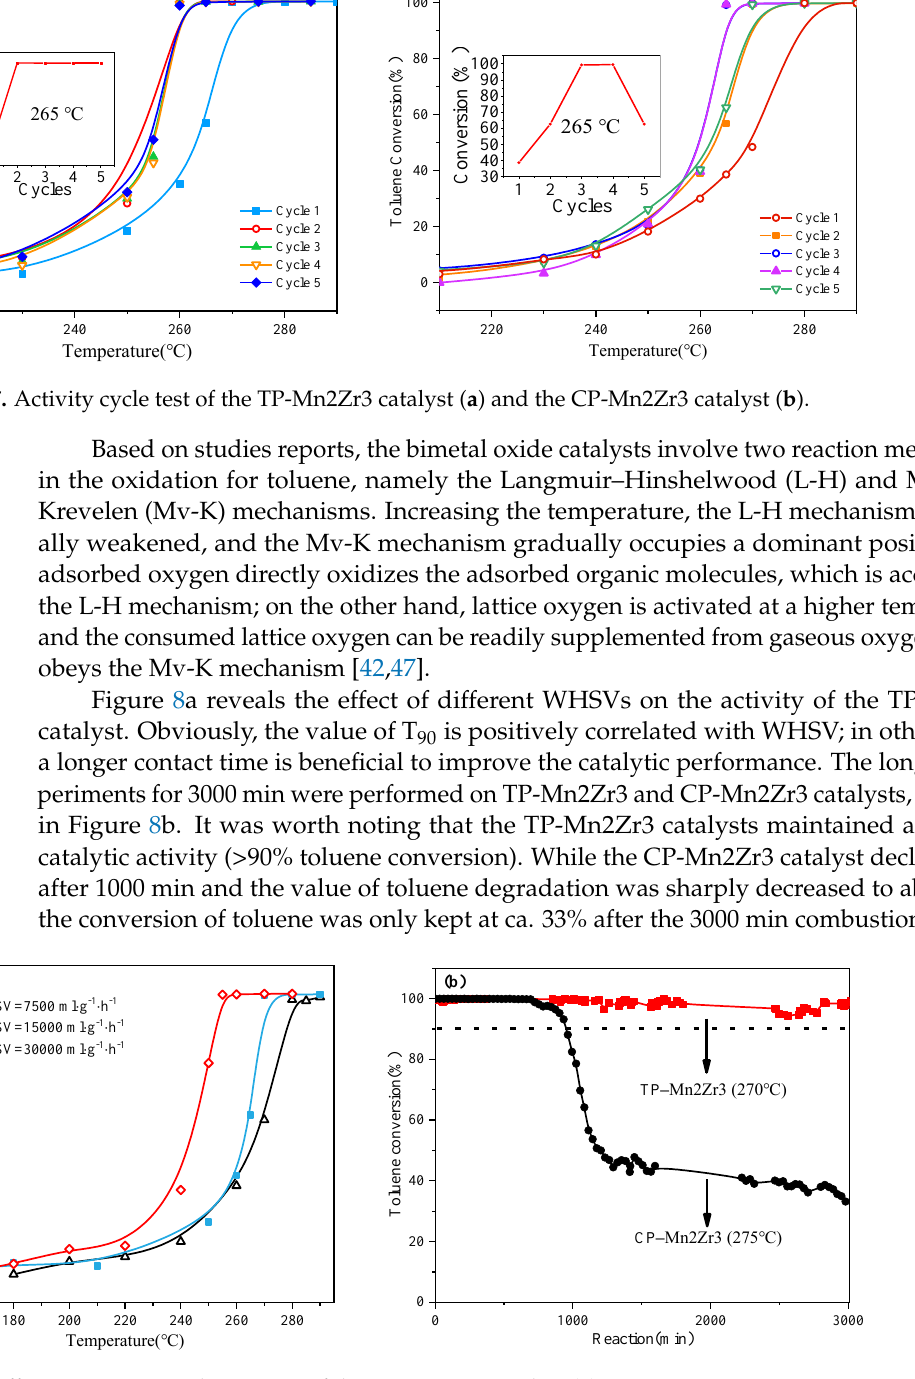
Figure 8. The effect of different WHSVs on the activity of the TP-Mn2Zr3 catalyst ( a ); Longevity test over TP-Mn2Zr3 and CP-Mn2Zr3 in 1000 ppm toluene ( b ).